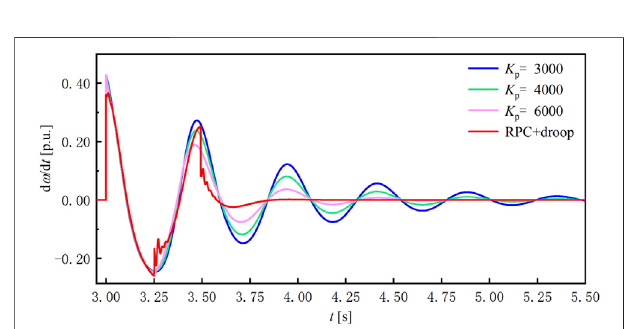
FIGURE 8 | Rate of change of rotor speed dominated by droop control